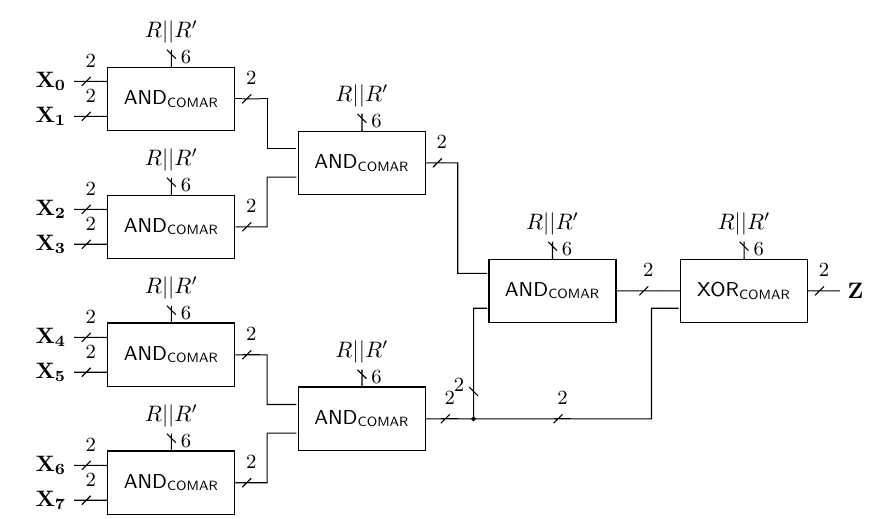
Figure 2: Exemplary circuit composed of COMAR